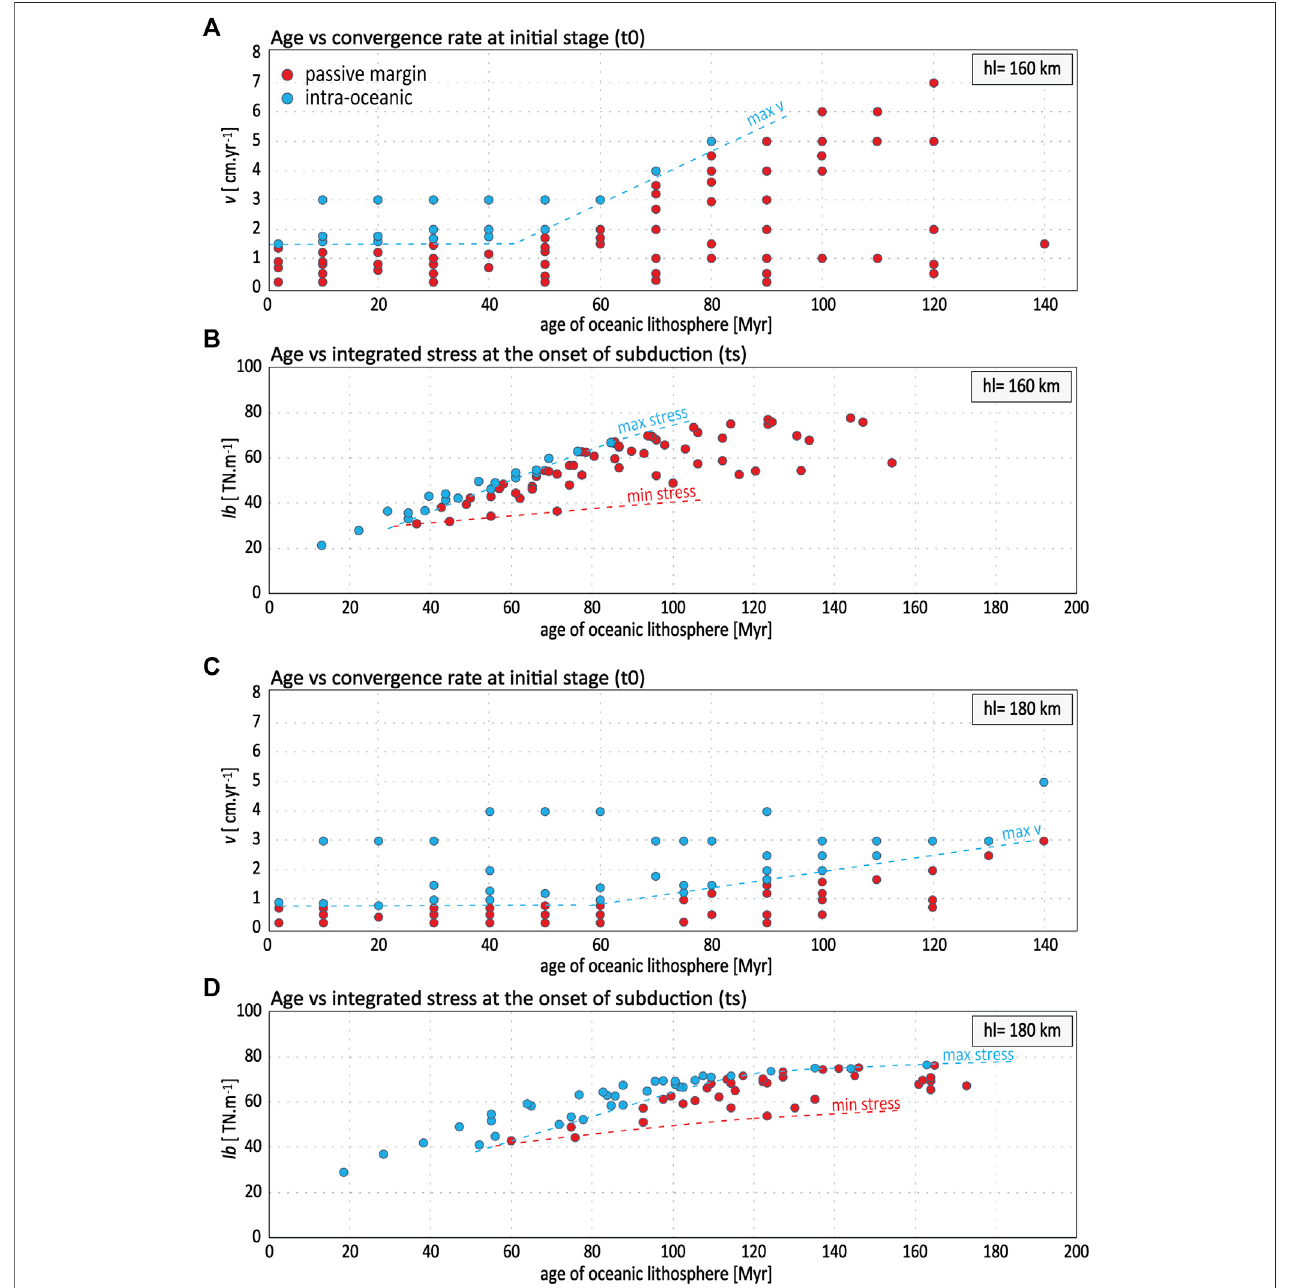
FIGURE4| Resultsofmodelseries1withlaterallyuniformthicknessofoceaniclithosphere:roleofstressandconvergencerateonthelocusofsubductioninitiation for two thermal thicknesses of continental lithosphere, 160 and 180 km. (A, C) Age of oceanic lithosphere vs convergence rate at model boundary at the onset of convergence(t0). (B,D) Ageofsubductionvsintegratedstressatmodelboundaryattheonsetofsubductioninitiation.Theredandbluedotlinesrepresenttheminimum and maximum integrated stress for subduction at passive margin.